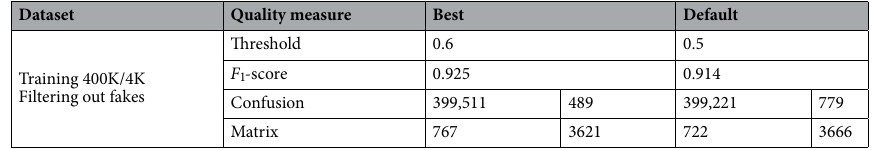
Table 7. Performance of synthetic traffic generated by standard WGANs after filtering fake samples by discriminator. Results on testing using the best models on training.